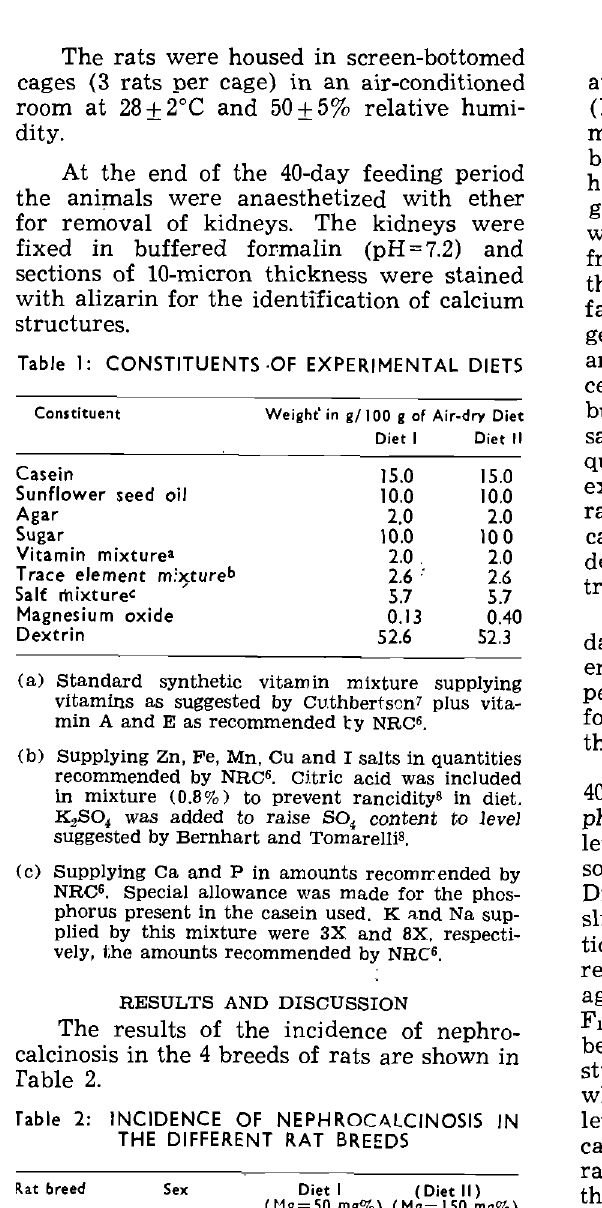
Table 2: INCIDENCE OF NEPHROCALCINOSIS IN THE DIFFERENT RAT